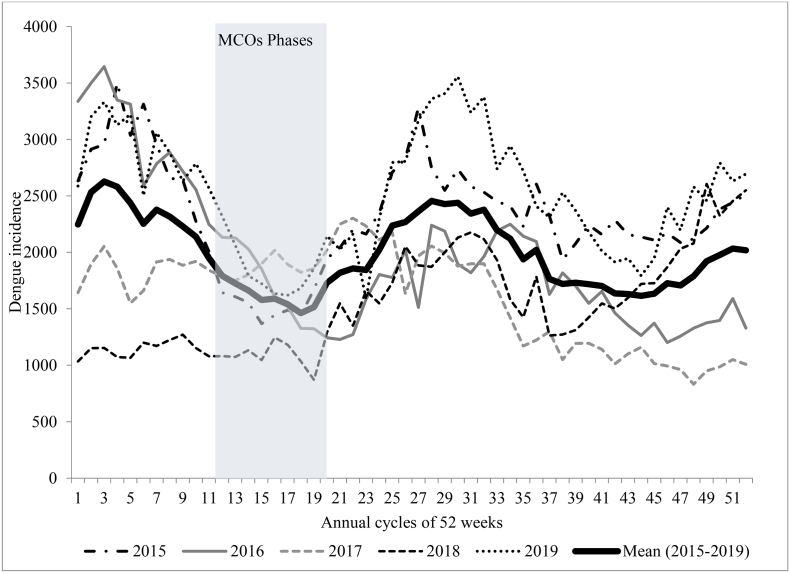
Annual cycle of dengue fever cases trend in Peninsular Malaysia from 2015 to 2019. Note: The grey area indicates the early stage of MCO implementation in Malaysia which consist of MCO I: 18th March to 31st March 2020, MCO II; 1st April 2020 to 14th April 2020, MCO III: 15th April to 28th April 2020).